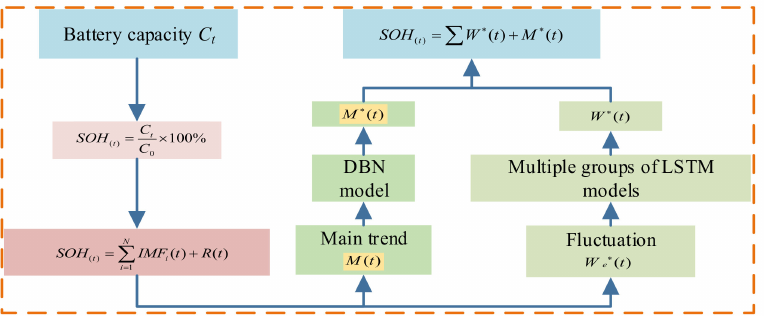
Figure 5. The overall flowchart of the DCNN-based SOH prediction method (“*” is a special symbol that is used to characterize new values different from M and W , which have been calculated by DBN and LSTM algorithms).